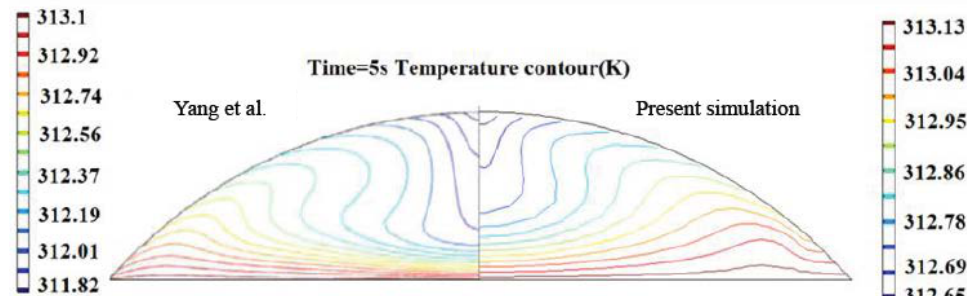
Figure 5. Present simulation results compared with Yang et al.’s work